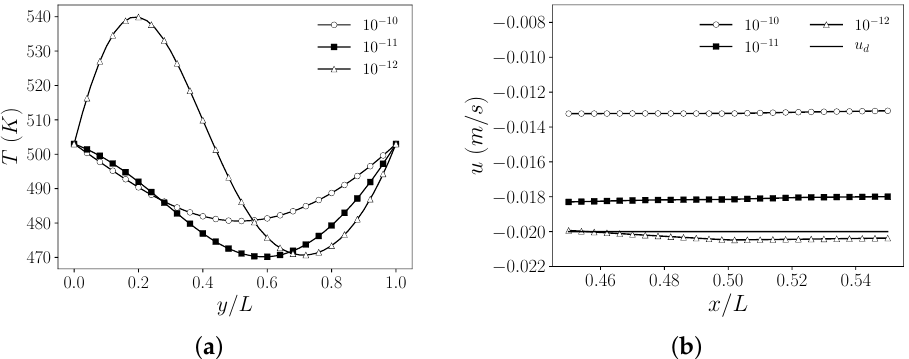
Figure 9. Velocity matching case with Dirichlet boundary control—Case 2: temperature profiles T plotted against y / L on the controlled boundary Γ c ( a ); x -component of the velocity u profiles plotted against y / L on the region Ω d along the line x / L = 0.2 ( b ). Numerical results for λ = 10 − 10 ,10 − 11 , and 10 − 12 . The target value u d is shown as a dotted